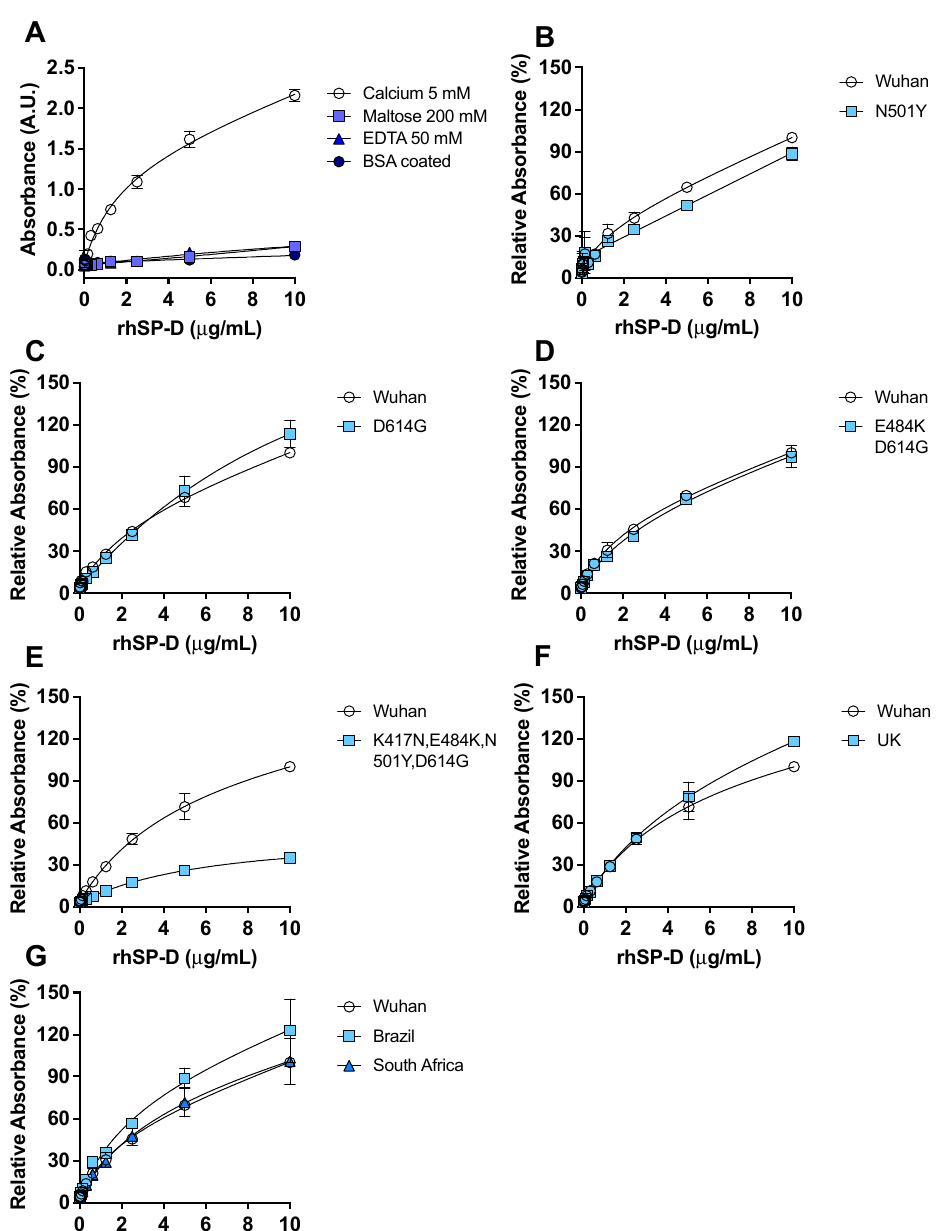
Figure 1. rhSP-D binds to the spike-(S)-protein of SARS-CoV-2. ELISA binding assays were performed, coating the plate wells with S 1 -protein. ( A ) The binding of rhSP-D to the Wuhan variant S 1 -protein was determined by anti-SP-D ELISA under different conditions: 5 mM calcium, 200 mM maltose, and 50 mM EDTA; additionally, wells were coated with bovine serum albumin (BSA) instead of S-protein to determine nonspecific binding of rhSP-D and show that the binding to the S-protein was specific. The binding of rhSP-D to S 1 -protein in the presence of calcium was significantly different to the binding of rhSP-D in the presence of maltose ( p = 0.004) or EDTA ( p = 0.02) (Kruskal–Wallis with Dunn’s post hoc test). Applying a one-binding site model the apparent Kd was 1.65 and the apparent B max was 1.35. Binding of rhSP-D to the S 1 -protein variant from Wuhan, compared to a S 1 -protein enclosing different mutations, was tested: N501Y ( B ), D614G ( C ), E484K + D614G ( D ) or K417N + E484K + N501Y + D614G ( E ); binding was significantly different in the last mutant compared to the Wuhan variant ( E ) p = 0.0005 (Wilcoxon test). ( F , G ) rhSP-D binding to relevant clinical variants of S 1 -protein (Wuhan, Brazil ( G ), South Africa ( G ) and U.K. ( F )) was determined and rhSP-D bound to all the variants tested; binding was significantly different in the Brazil variant compared to the Wuhan variant ( G ) p = 0.002 (Friedman with Dunn’s test). n = 4, error bars represent standard